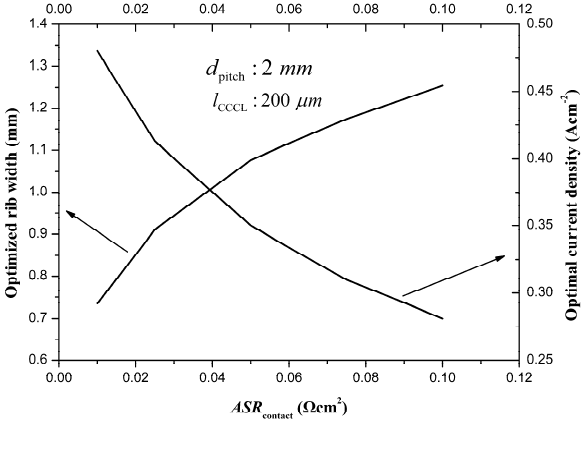
Figure 8. The optimized rib width and the optimal output current density vs the area specific contact